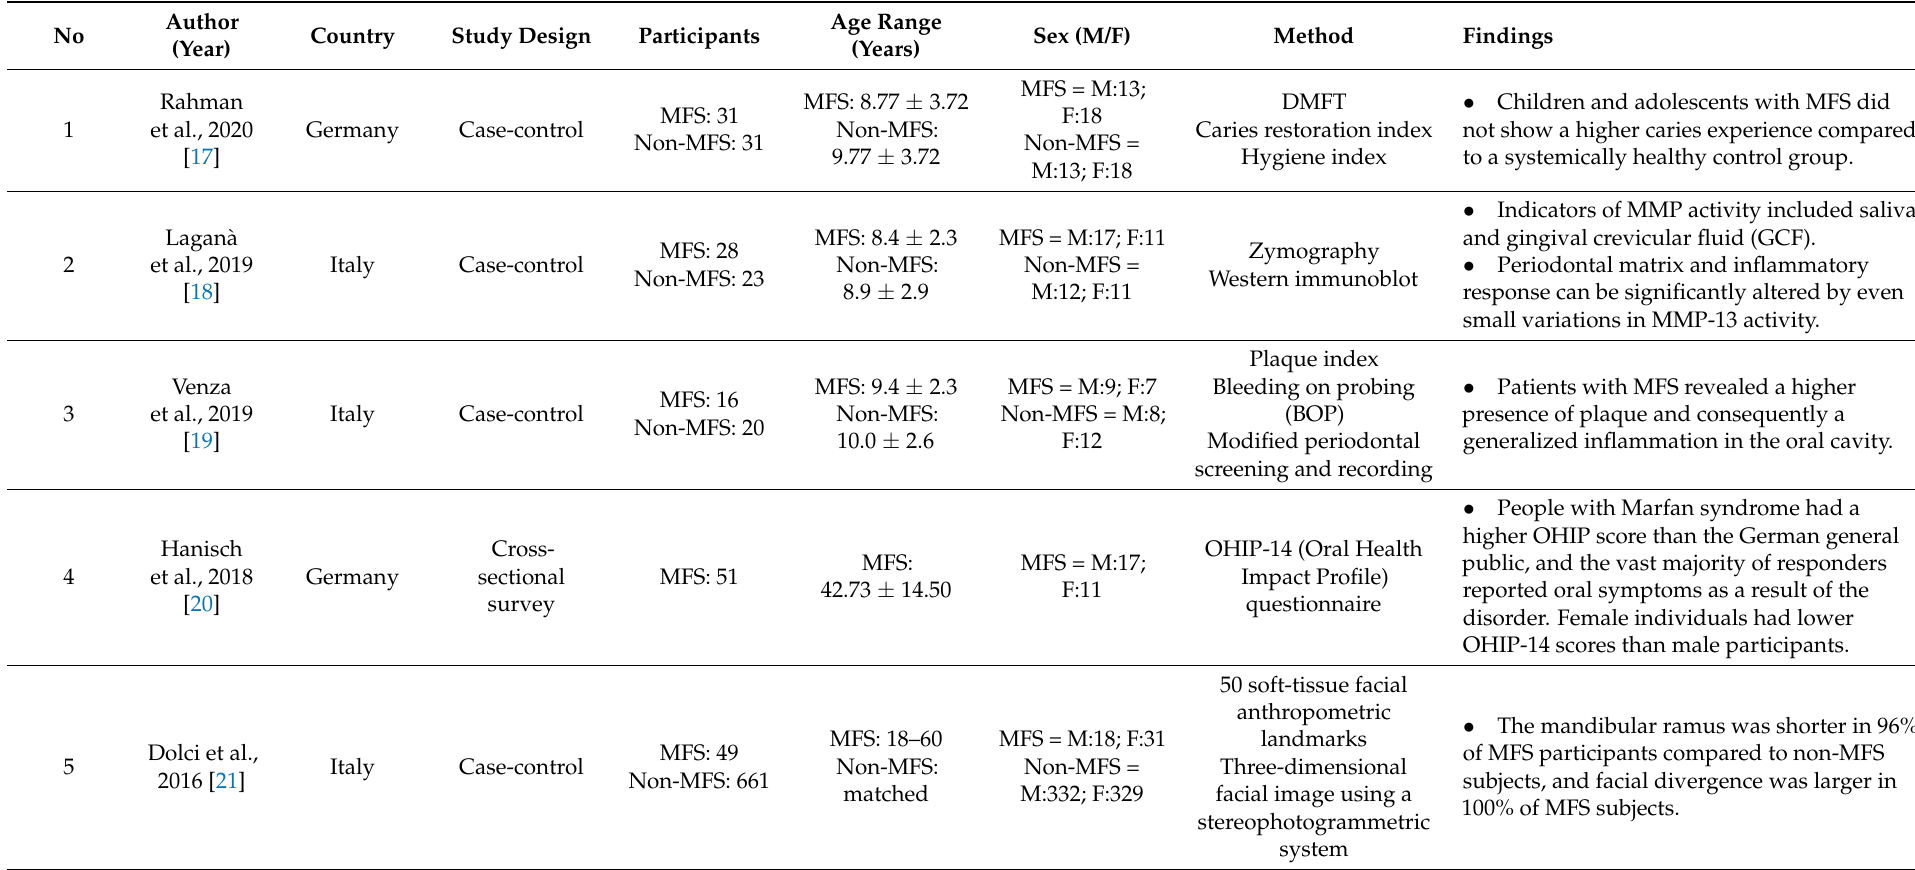
Table 1. Characteristics of the studies included in the systematic